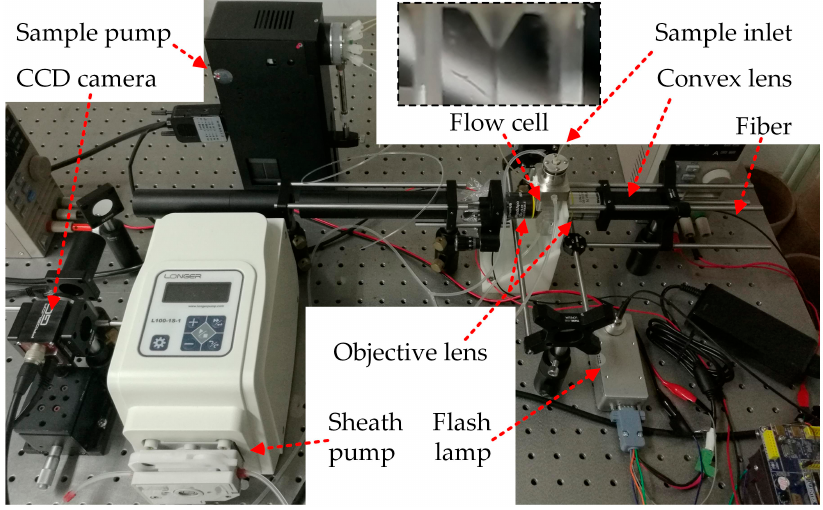
Figure 8. Experimental configuration of the microscopic imaging system. The flow cell is enlarged and shown in the dashed box.